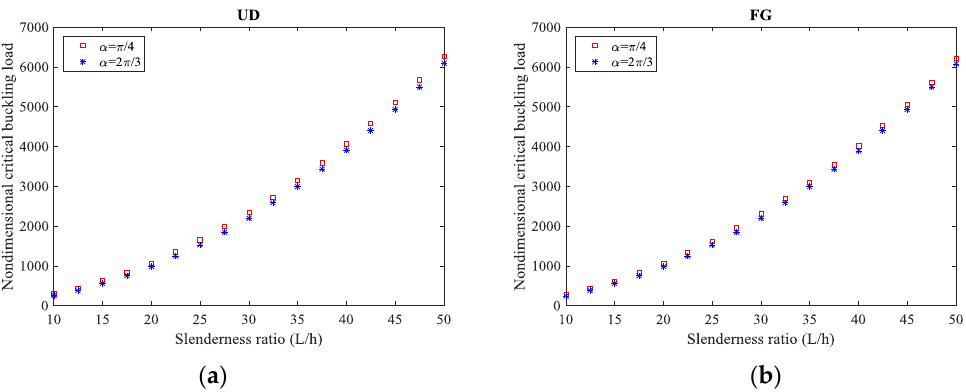
Figure 5. Critical buckling load versus slenderness ratio for di ff erent opening angles and distribution patterns of CNTs: ( a ) UD pattern, ( b ) FG pattern. ( µ = 1 nm 2 , L = 20, V ∗ = 0.14